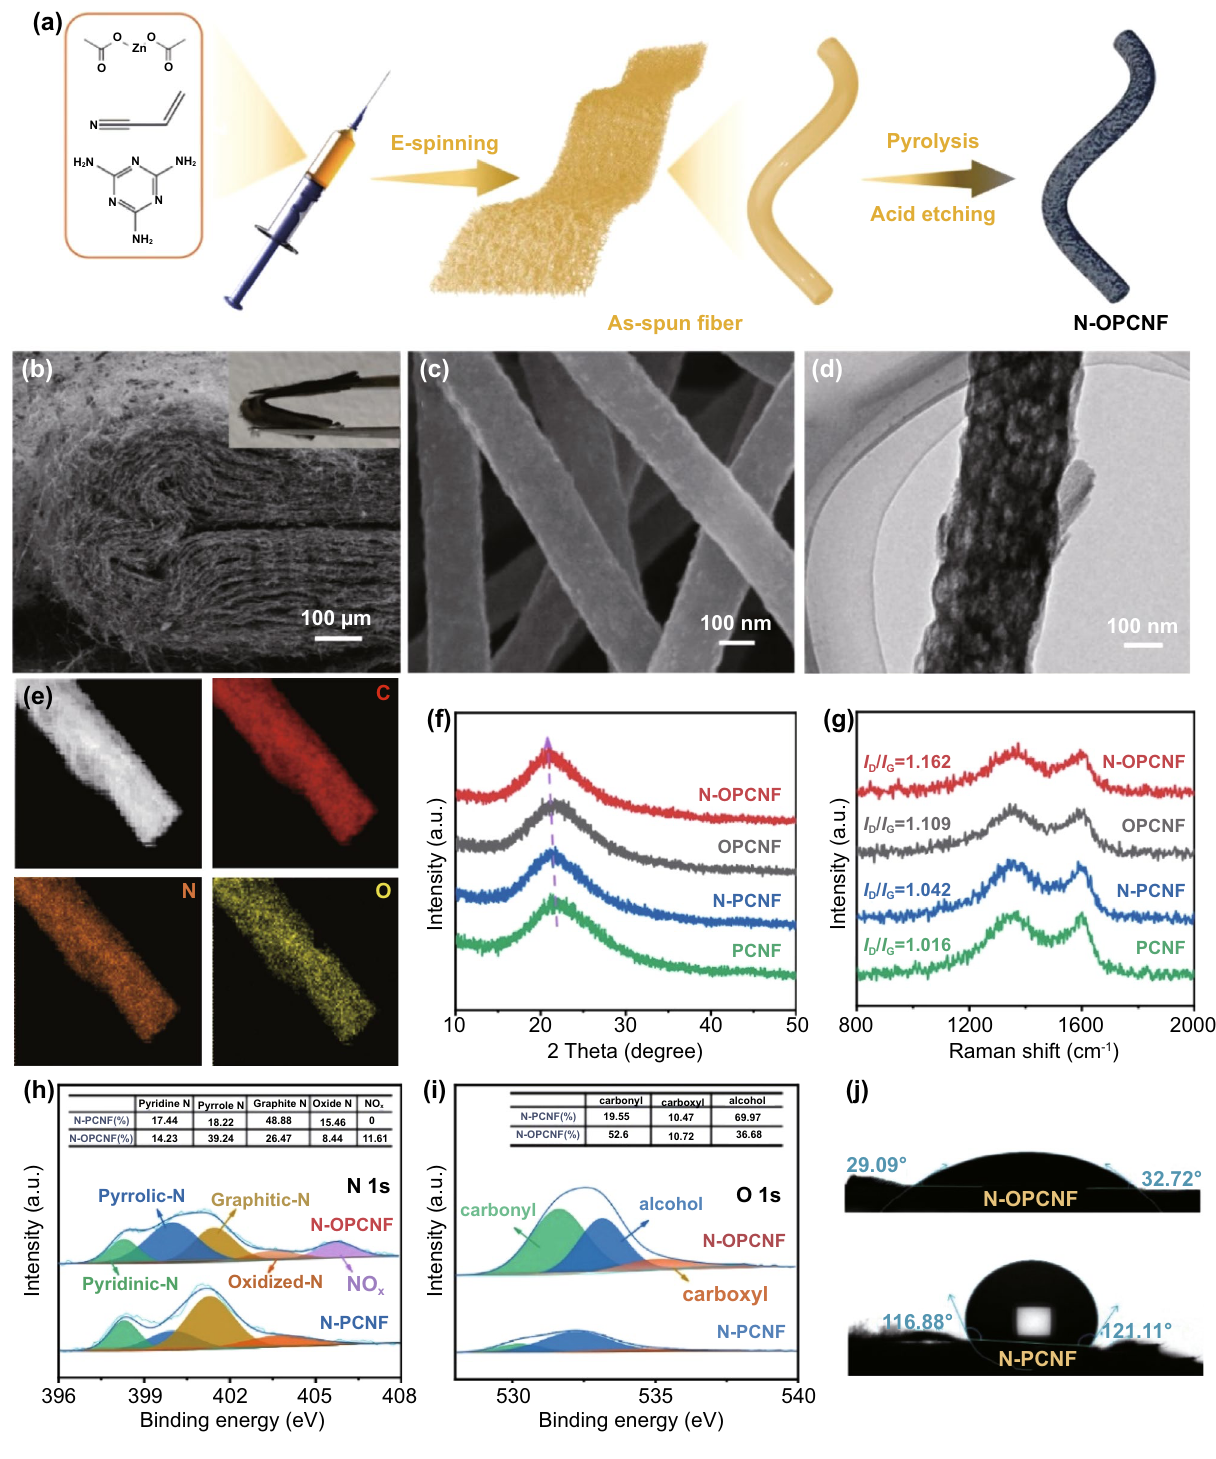
Fig. 1 a Schematic illustration, b , c SEM image, d TEM image, e high-angle annular dark-field STEM image and corresponding elemental mapping of N-OPCNF. f XRD pattern and g Raman spectra of N-OPCNF, OPCNF, N-PCNF, and PCNF. h High-resolution N 1 s and i O 1 s XPS spectra of N-OPCNF and N-PCNF. j Contact angles of a water droplet on N-OPCNF and N-PCNF